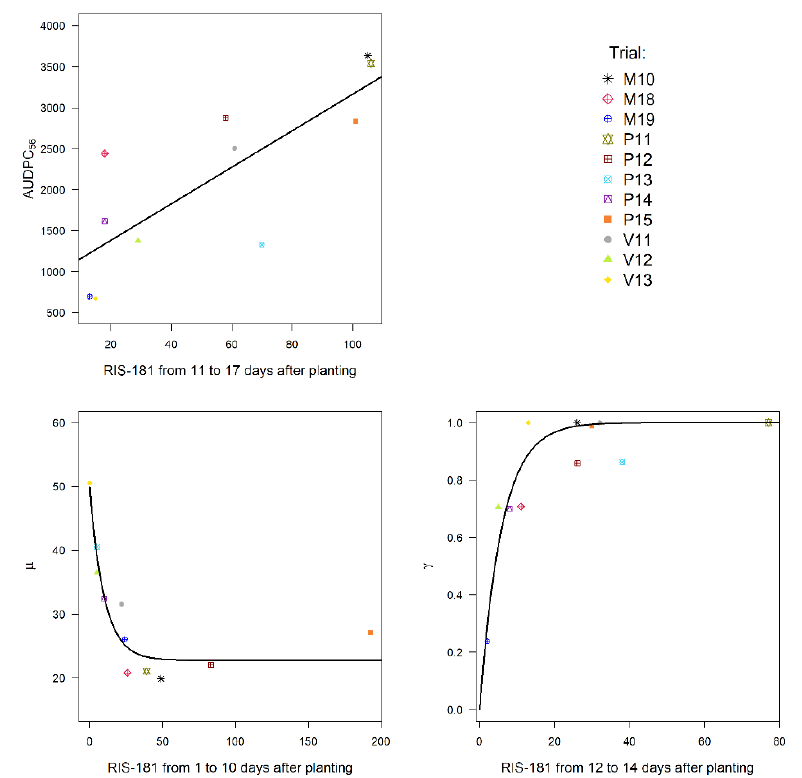
Figure 3. Best models obtained between the virus variables (dependent) and the aphid variables (explanatory). A linear model ( 𝑧 𝑘 = 𝐴 0 + 𝐴 1 . 𝑥 𝑘 ) was used for the area under the disease progress (explanatory). A linear model ( z k = A 0 + A 1 . x k ) was used for the area under the disease progress curve (AUDPC) and an exponential model ( z k = B 0 + B 1 curve (AUDPC) and an exponential model ( 𝑧 𝑘 = 𝐵 0 + 𝐵 1 (1 − 𝑒 −𝐵 2 .𝑥 𝑘 ) ) was used for two parameters logistic equation ( µ , γ of the logistic equation (µ, γ).